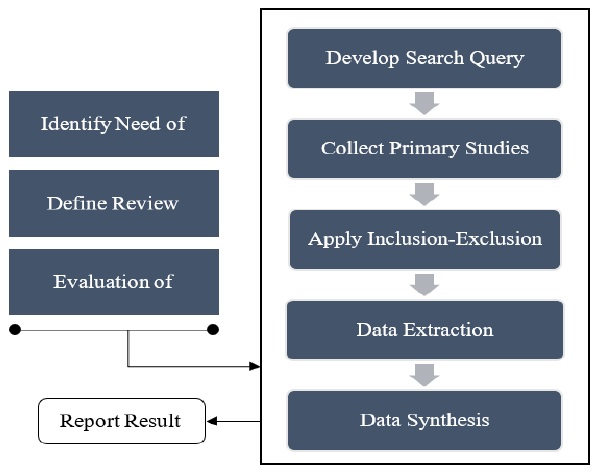
Figure 1. Literature review process.